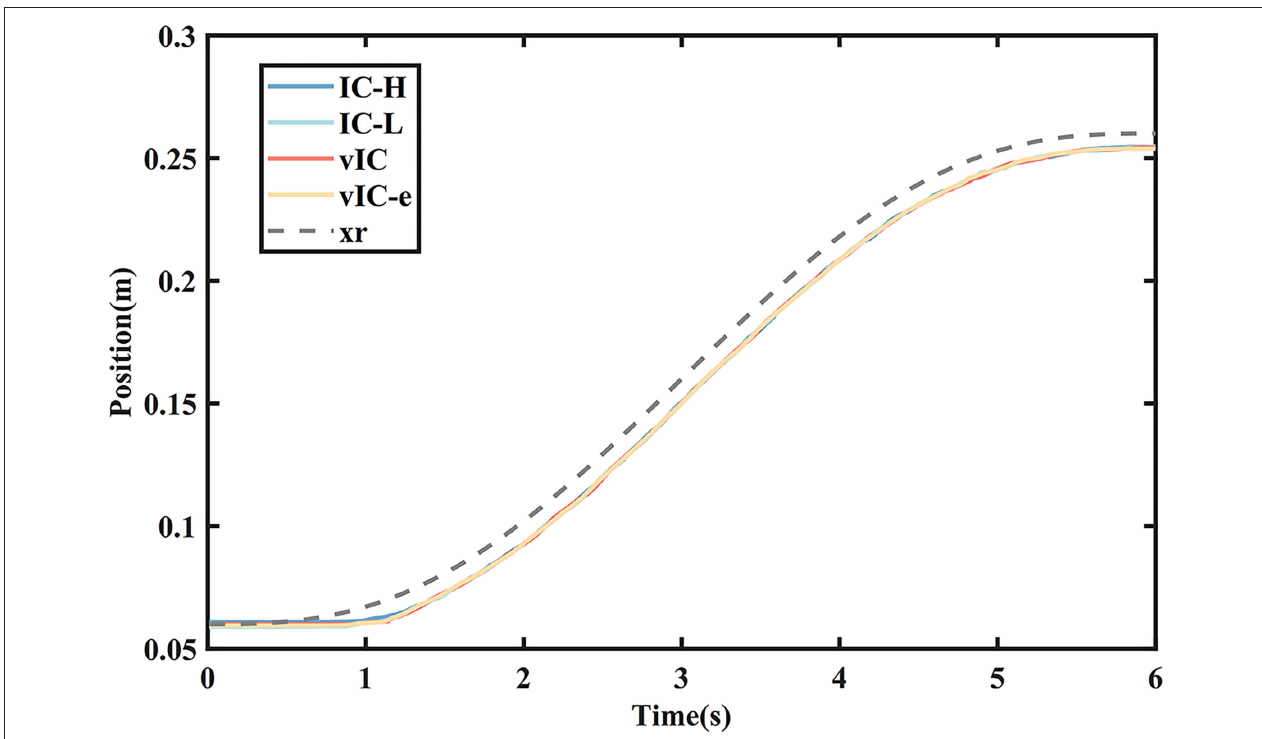
FIGURE 6 | The actual (solid lines) and desired (gray dashed line) trajectory profile of four control algorithms during a rightward subtask.